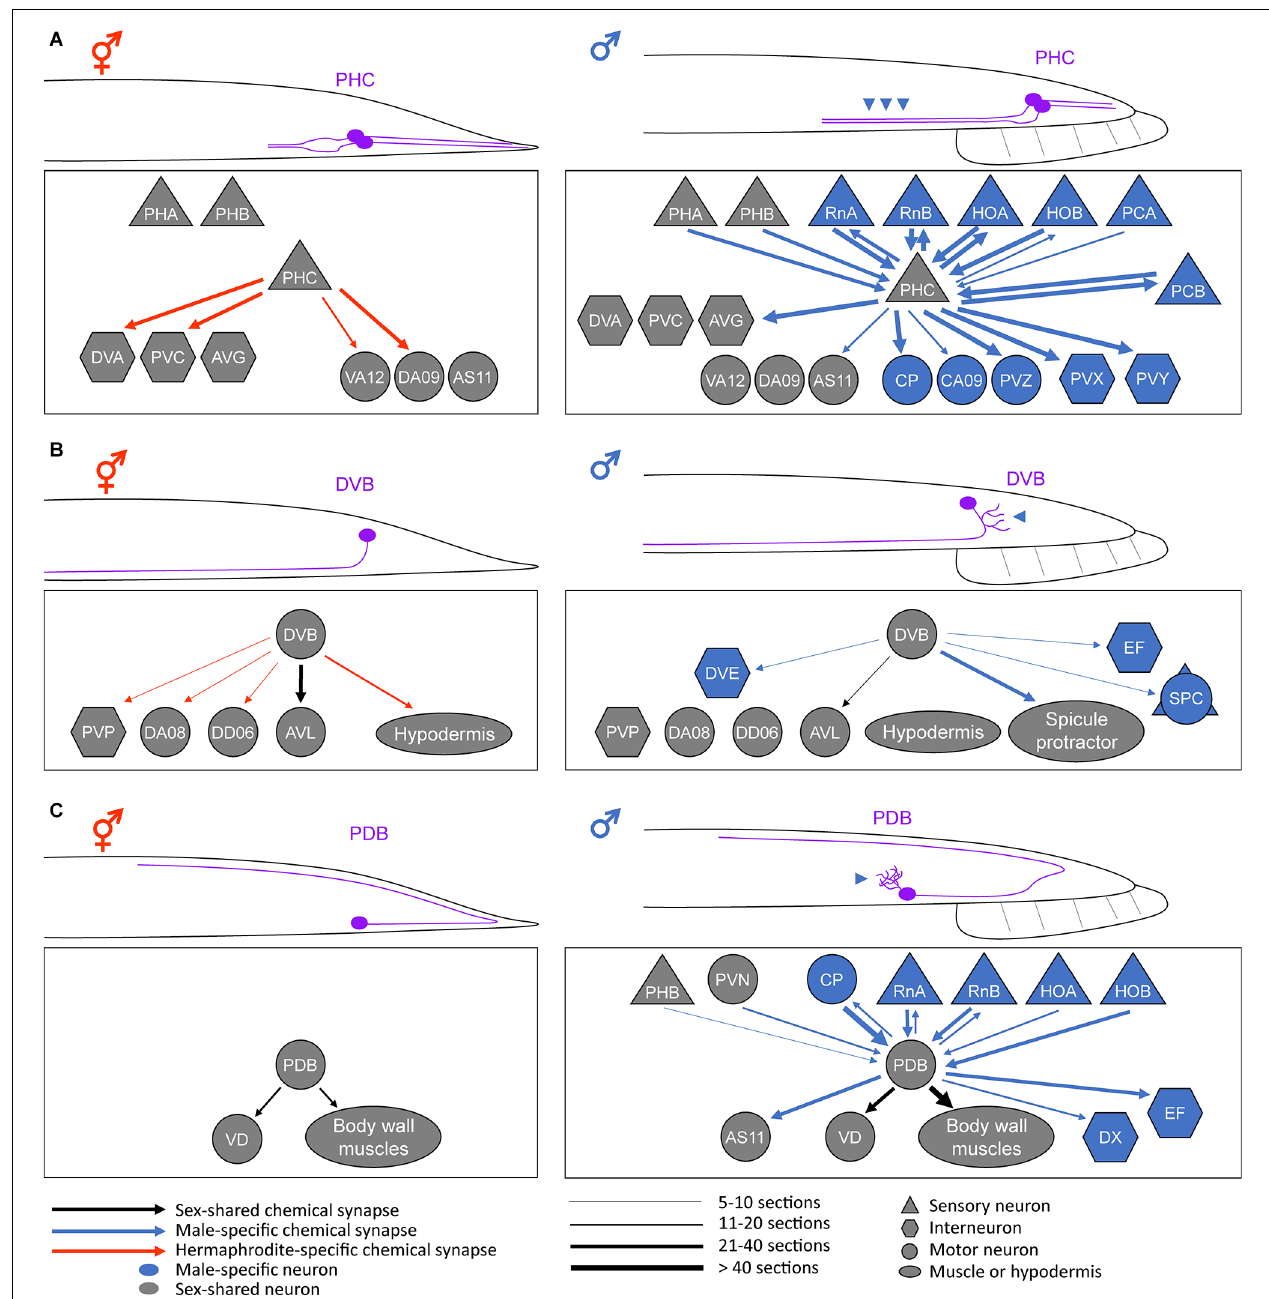
FIGURE 1 | Anatomical sex differences in the sex-shared neurons. Schematic diagrams of the sexually dimorphic neurite morphology and synaptic connectivity in a pair of PHC neurons (A) , DVB neuron (B) , and PDB neuron (C) . For simplicity, only the posterior half of a worm is drawn. Neurite or neurite branches specifically elongated in males are indicated by the arrowheads. For the connectivity, the synaptic weights of the chemical synapses (calculated based on the numbers of electron-micrograph sections) are depicted based on Cook et al. (2019). Note that the sex differences in neurite morphology largely affect the neural connectivity pattern, thereby resulting in different circuit functions (see text). Adapted from Serrano-Saiz et al. (2017a), Hart and Hobert (2018), and Pereira et al.